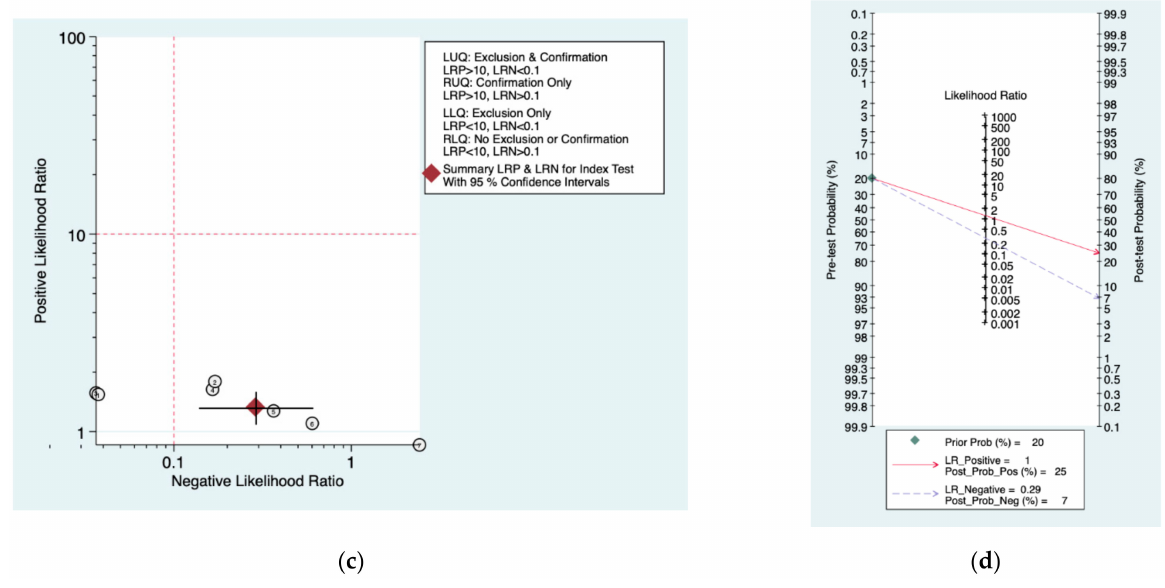
Figure 12. Meta‑analysis of Nashville protocol. ( a ) Forrest plot of pooled sensitivity and specificity [8,10,22,24,25]; ( b ) Hierarchical summary receiver operating characteristic (HSROC) curve; ( c ) Likelihood ratio scattergram; ( d ) Fagan